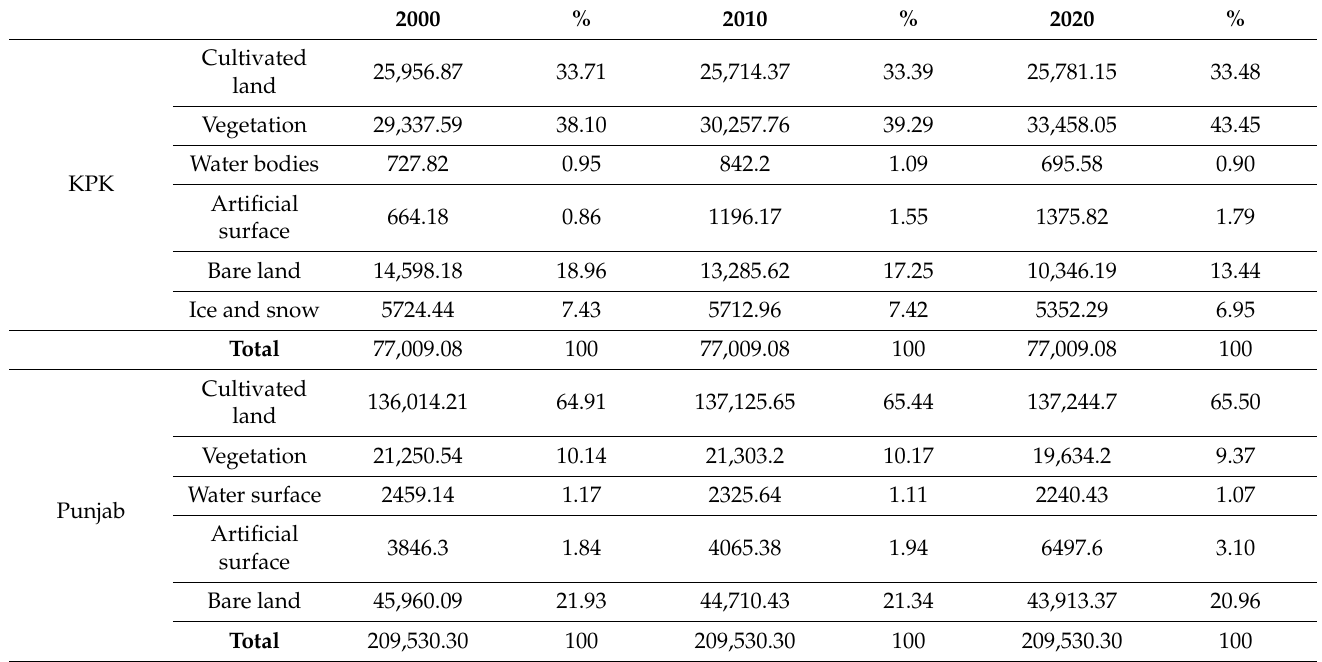
Table 2. Trends of LULC in KPK (top) and Punjab (bottom) provinces between 2000 and 2020 (km 2 ). 2000 % 2010